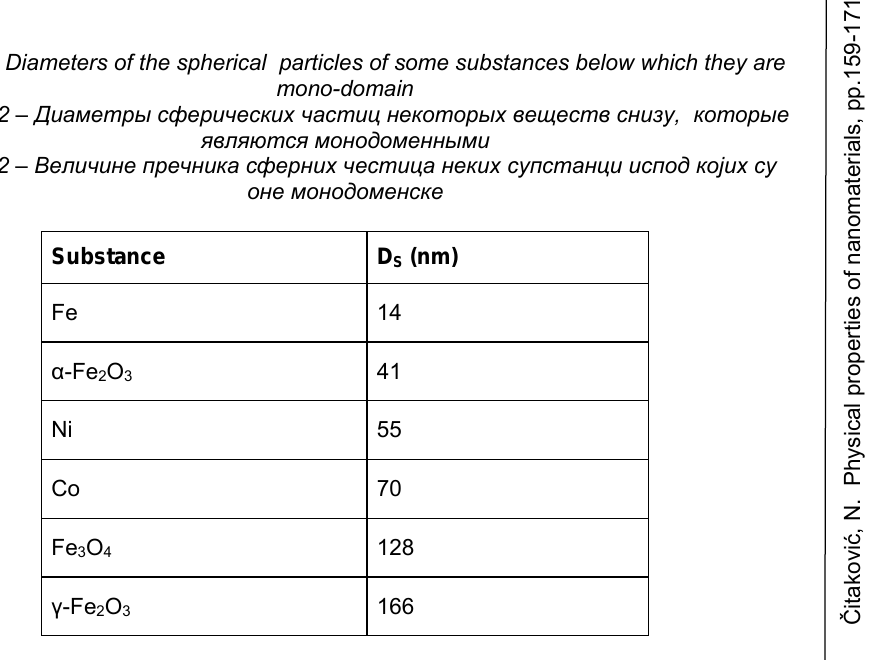
Table 2 – Diameters of the spherical particles of some substances below which they are